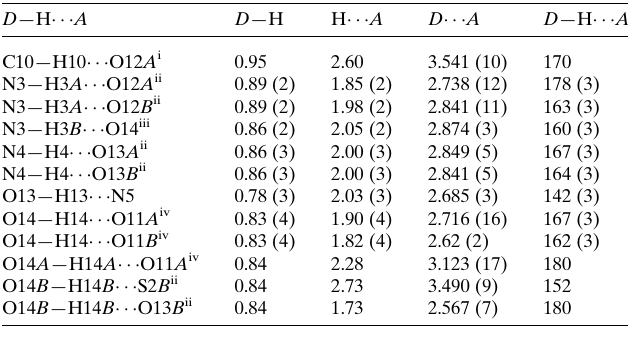
Table 1 Hydrogen-bond geometry (A˚ , (cid:5) ).